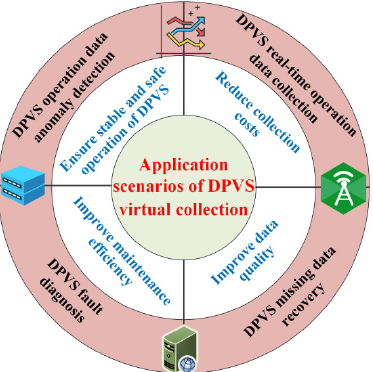
Figure 12. Application scenarios of DPVS virtual collection technology.